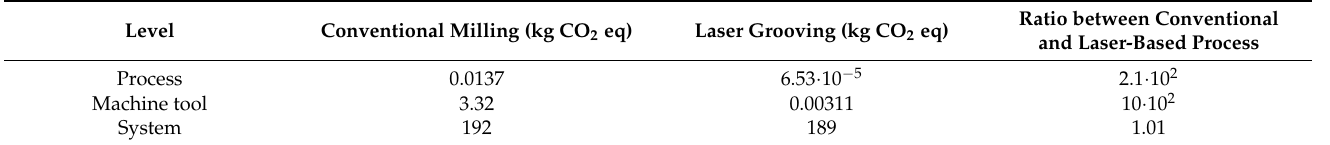
Table 8. Comparison of carbon footprint per level between conventional milling and laser grooving.